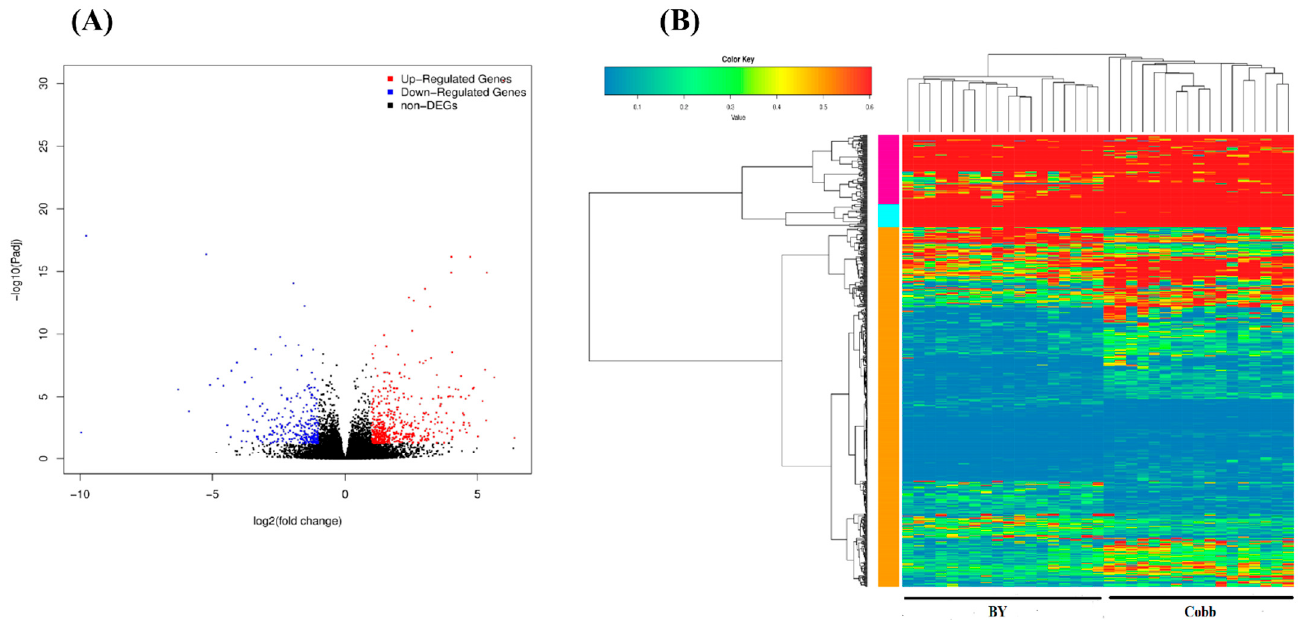
Figure 2. ( A ) Volcano plot showing differentially expressed genes (DEGs) in spleen between BY and Cobb chickens after Salmonella infection (log2 FC ≥ 1 and padj < 0.05). ( B ) The heat map based on DEGs of the RNA-seq data.